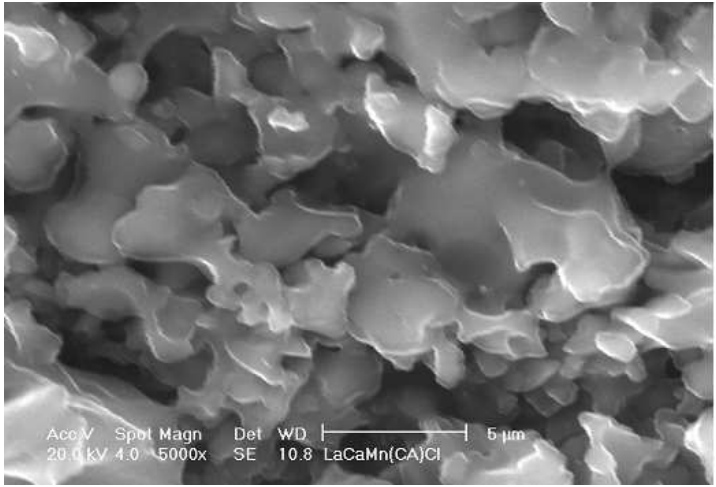
Table 3 Some main characteristics of the studied